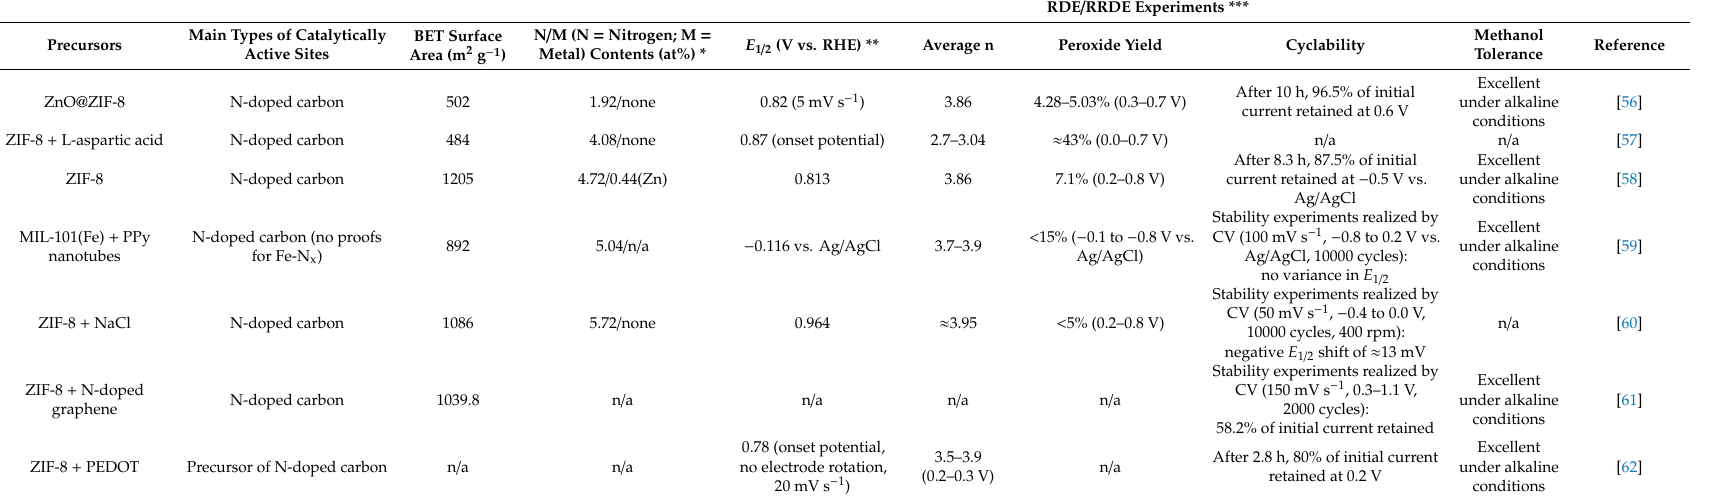
Table 1. Recent research works (2018–2020) dealing with the preparation of N-doped carbonaceous electrocatalysts for fuel cells with a focus on ORR activity. Examples in alkaline media are provided, and major physicochemical properties and electrochemical performances realized using rotating electrodes are